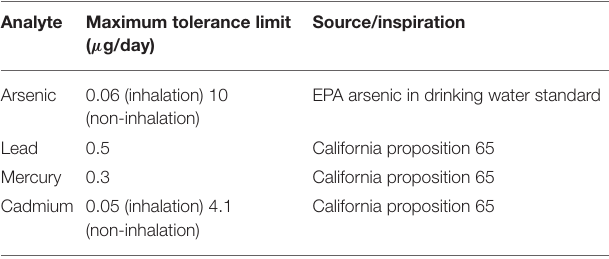
TABLE 10 | Maximum tolerance limits set by the Clean Label Project for heavy metal